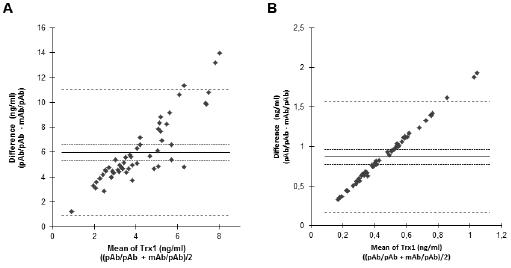
Figure 6. Agreement of the level of Trx1 in CSF samples by pAb/pAb and mAb/pAb capture ELISA. Fifty-seven CSF samples Figure 5. Agreement of the level of Trx1 in plasma samples by from patients with diverse diagnosis were analysed for the level of Trx1 pAb/pAb and mAb/pAb capture ELISA. The agreement between using the ELISA formats pAb/pAb and mAb/pAb in the presence of the two ELISAs used for analysis of eighteen plasma samples from either incubation buffer or a HA blocking buffer. The agreement healthy blood donors and diluted in incubation buffer (A) or HA between the two ELISA formats used for analysis of samples diluted in NNNNNNNNNNNN blocking buffer (B) was assessed with Bland-Altman analysis. One of two incubation buffer (A) or HA blocking buffer (B) was assessed with Bland- NNNNN NNNNNNNNNNNN experimentswithsimilarresultsisshown.–––Bias Altman analysis. One of two experiments with similar results is shown. CI Bias (95%) – – – – CI (95%). CI Bias (95%) – – – – CI (95%). ––– Bias doi:10.1371/journal.pone.0103554.g005